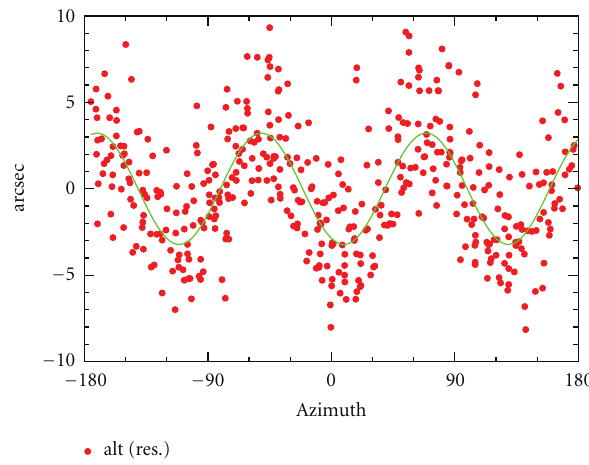
Figure 4: The RMS of the elevation pointings after a classical pointing model has been applied compared to the true o ff sets. The RMS varies at an amplitude of ≈ 3 (cid:6)(cid:6) , at a wavenumber k = 3, reminiscent of the tripod mounting of the